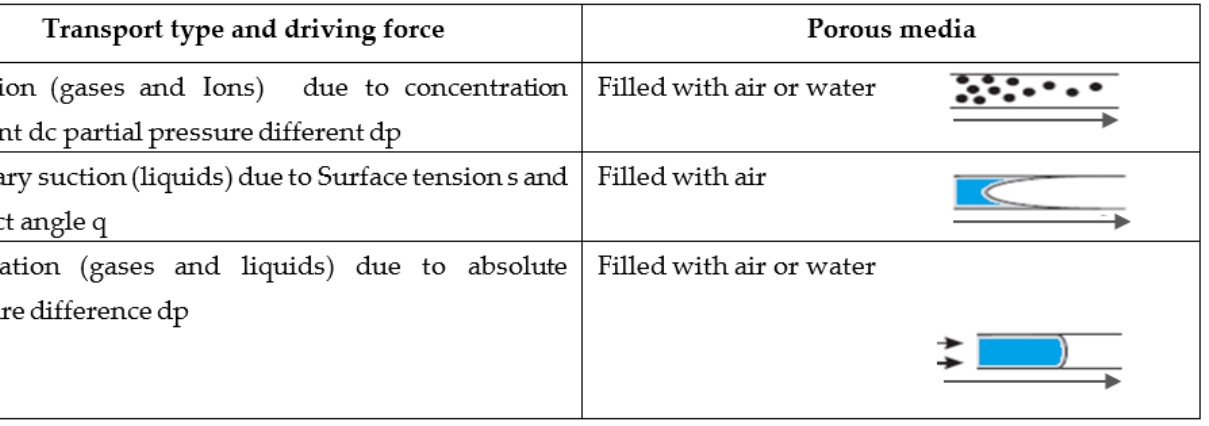
Figure 3. The different types of transport processes in an earth or cement-based medium based on Ref. [33].